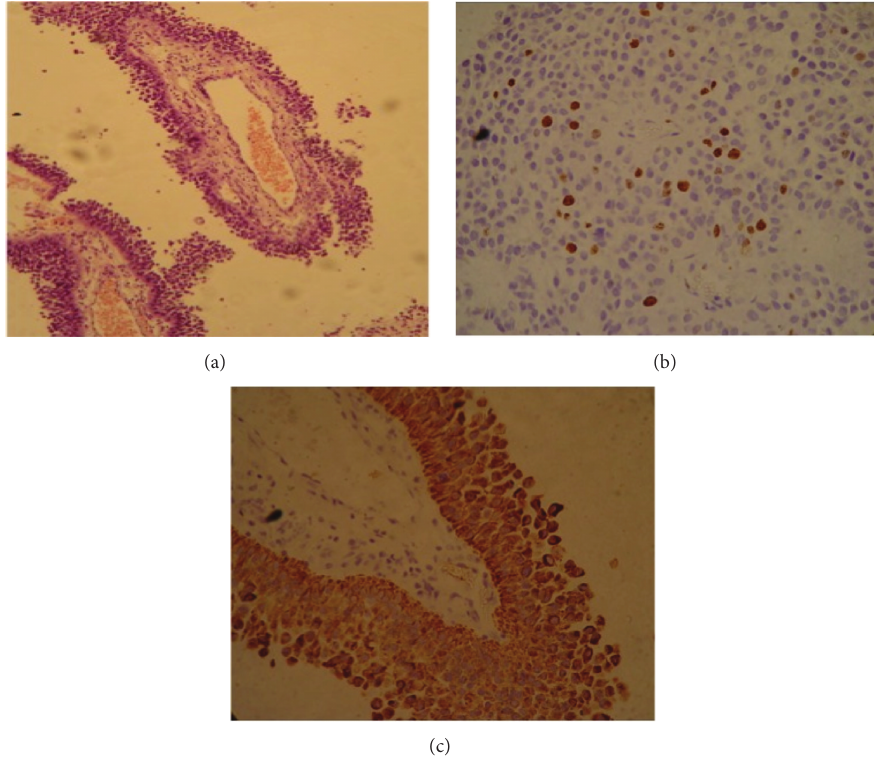
Figure 2: Histology of the tumor showing papillary projections (a) based on hematoxylin eosin (HE) staining. Immunohistochemistry showing 20% positive Ki67 (b) and the high expression of cytokeratin, an immunophenotype characteristic of PTPR